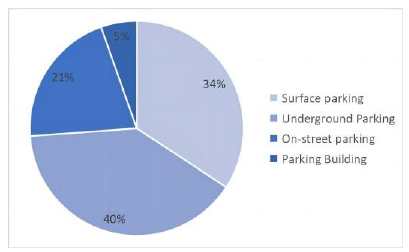
Figure 8. Proportion of parking facility options.